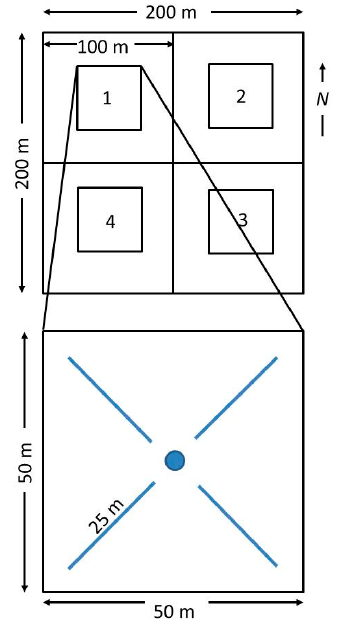
Figure 2. Layout of nested-vegetation survey locations for field validation in each of the 80 field plots [32].